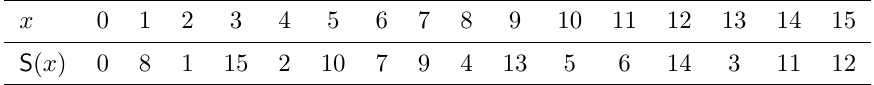
Table 1: S-box in table